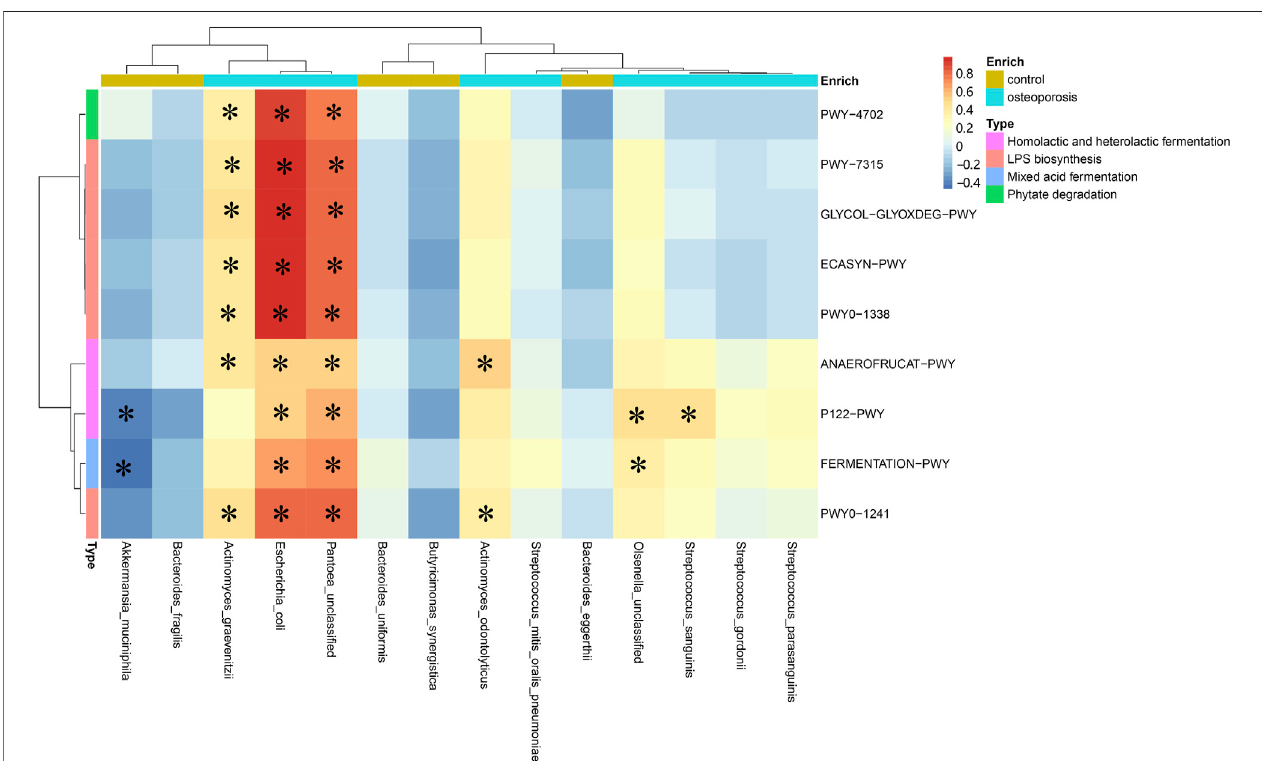
FIGURE 5 | Spearman ’ s correlation matrix for microbial pathways and species. Blue signi fi es a negative correlation, while yellow and red signify a positive correlation. Cells with an asterisk indicate p < 0.05.